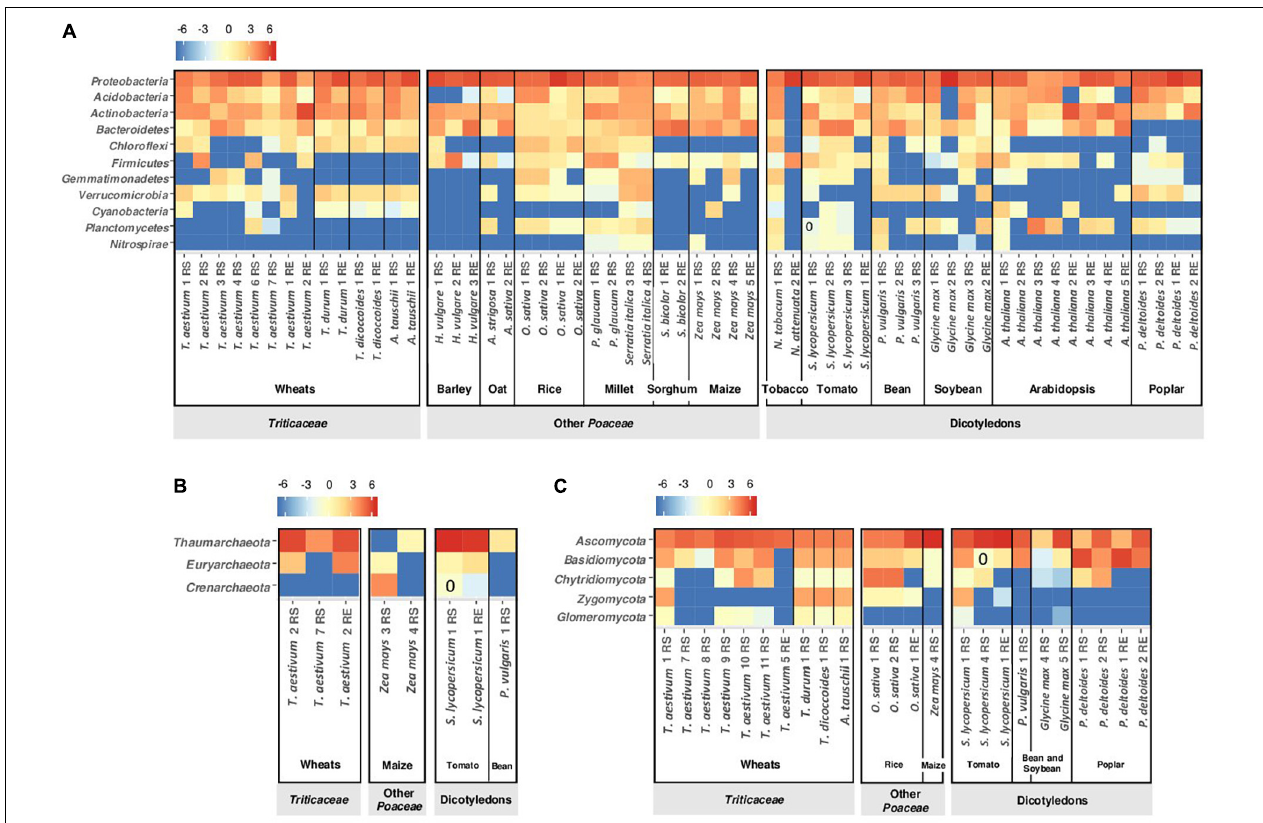
FIGURE 3 | Heatmap of major phyla affiliated with (A) bacteria, (B) archaea, and (C) fungi in rhizosphere soil (RS) and root/endosphere (RE) of wheats and non-wheat plants based on results from selected studies. Only phyla with relative abundance > 0.5% in at least one study are shown. The color intensity in each cell denotes the transformed relative abundance [log 2 ((100x)+0.02)] of a phylum in each study for each plant type. For details on individual conditions, see Supplementary Table 1